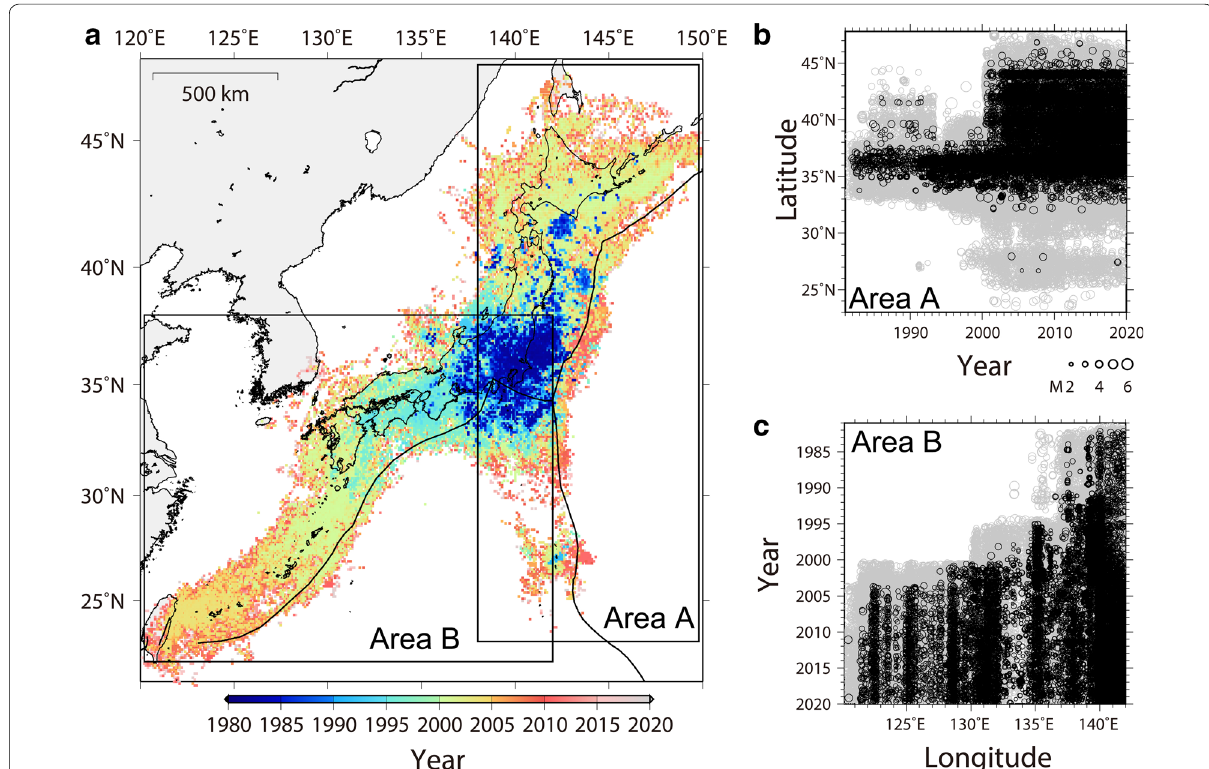
Fig. 2 a Timing of the first analyzed events across the study region. b Latitude–time diagram for Area A. c Longitude–time diagram for Area B. Black and gray symbols denote the similar earthquakes and analyzed earthquakes, respectively